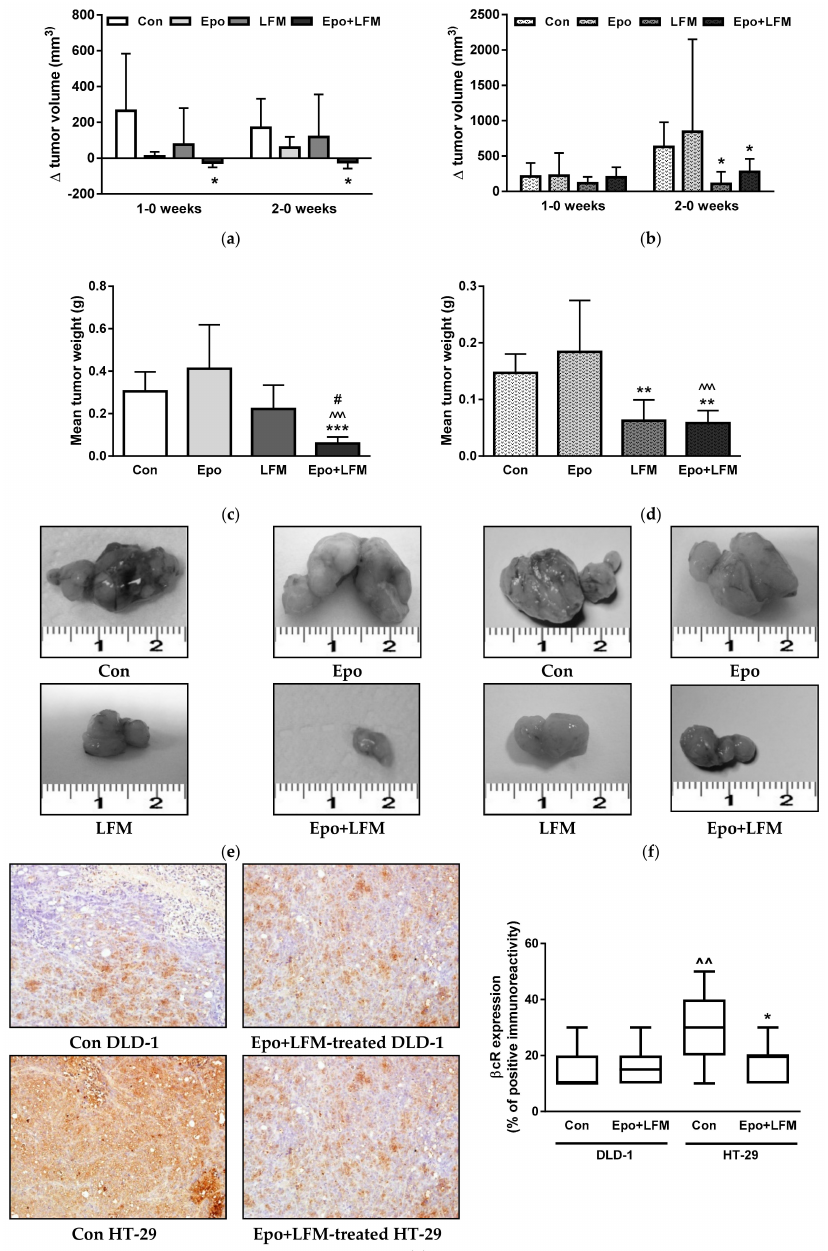
Figure 4. Effect of the combined activity of LFM-A13 and erythropoietin β on a mouse model of colorectal cancer. Impact on tumor volume in DLD-1 ( a ) and HT-29 ( b ) xenografts; 0—before substance administration, 1—afterfirst weekofsubstance administration, 2—aftersecondweek ofsubstanceadministration. The results are presented as mean values ± SD, n = 5–10. Effect of the combined activity of LFM-A13 (10 mg/kg b.m.) and erythropoietin β (Epo, 600 IU/kg b.m.) on tumor weight in DLD-1 ( c ) and HT-29 ( d ) xenografts. The results are presented as mean values ± SD, n = 10. * p < 0.05 (vs. Con), ** p < 0.01 (vs. Con), *** p < 0.001 (vs. Con); ˆ p < 0.05 (vs. Epo), ˆˆ p < 0.01 (vs. Epo), ˆˆˆ p < 0.001 (vs. Epo); # p < 0.05 (vs. LFM-A13). Representative weights of the tumors dissected from the nude mice untreated or treated with Epo, LFM-A13, and Epo+LFM-A13 in DLD-1 ( e ) and in HT-29 ( f ). ( g ) Positive expression of β cR in the cytoplasm of colon cancer xenografts. Left panel: expression in control and Epo-LFM-A13-treated DLD-1 and HT-29 xenografts (H&E staining; magnification, × 200). Right panel: a box-and-whisker plot of percentage β cR expression in DLD-1 and HT-29 tumor xenografts. The results are presented as medians (minimum–maximum), n = 10, * p < 0.05 (vs. Con), ˆ p < 0.05 (Con in DLD-1 vs. Con in HT-29